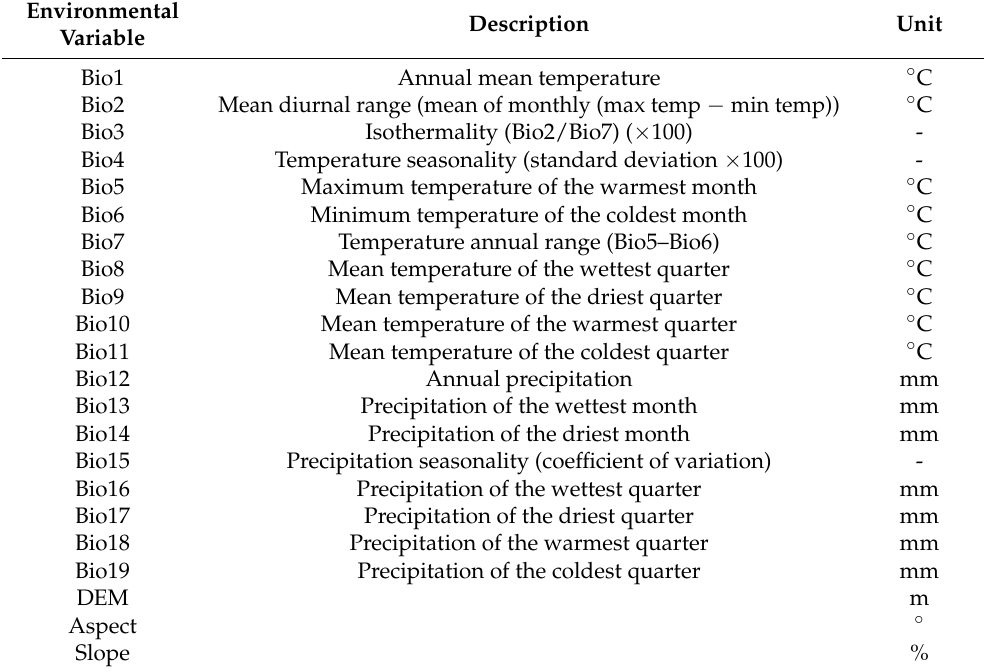
Table 1. Environmental variables related to the distribution of S. delavayi